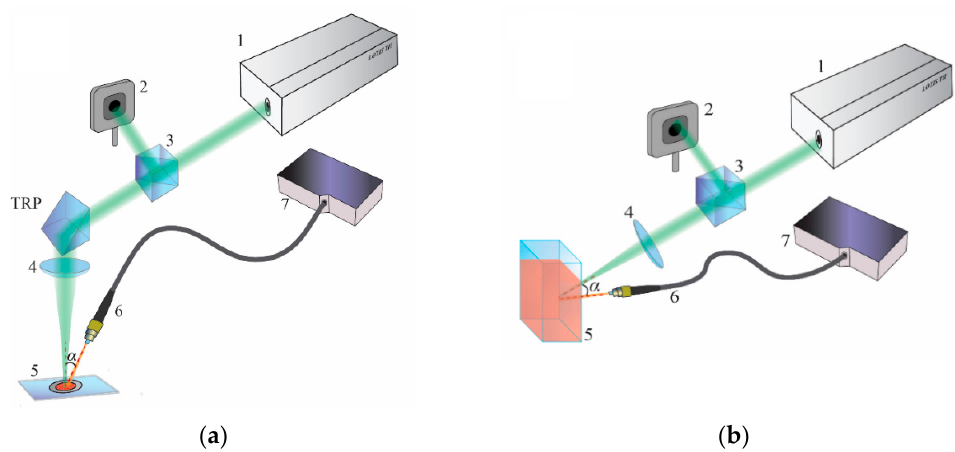
Figure 1. The scheme of the experimental setup. ( a ) Examination of samples #1 (layers); ( b ) exami- nation of samples #2 (suspensions). 1—laser; 2—energy meter; 3—beam-splitter; 4—convex lens; 5—sample, 6—fiber-optic patch cord, 7—spectrometer; TRP—totally reflecting